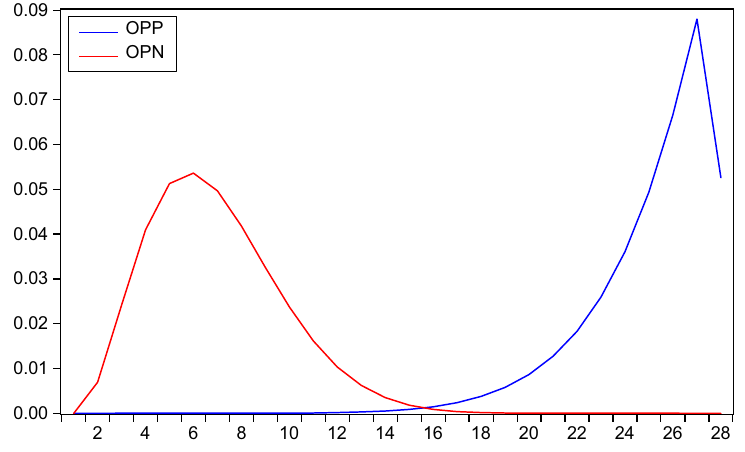
Figure 7. Thelaggedpatternsfor coefficients of OPP and OPN in the inflation